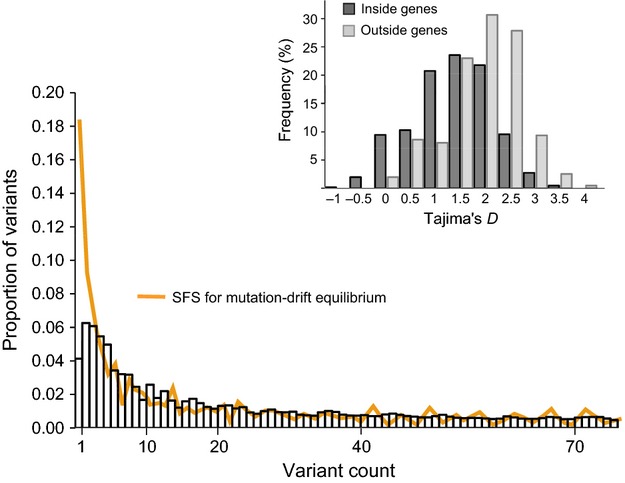
Tajima's D and site frequency spectrum (SFS) for nuclear single nucleotide polymorphisms (SNPs). Tajima's D values for sites in regions inside and outside genes and folded SFS for the genomewide SNPs and in the empirical dataset (Aedes aegypti from Rio de Janeiro) and the dataset simulated under mutation-drift equilibrium.